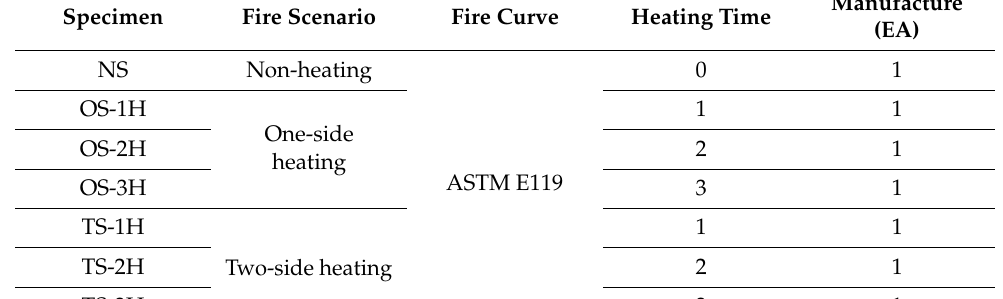
Table 8. Wall-slab connection specimen test plan.